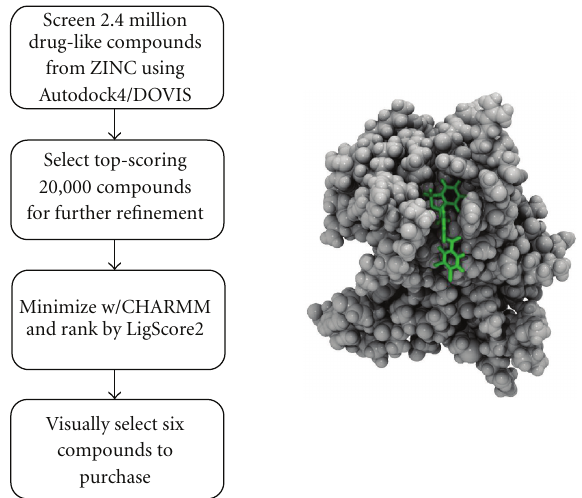
Figure 3: Strategy for computational screening of budding inhibitors. The stereo view of the PTAP motif (green) in its binding groove on the UEV domain of